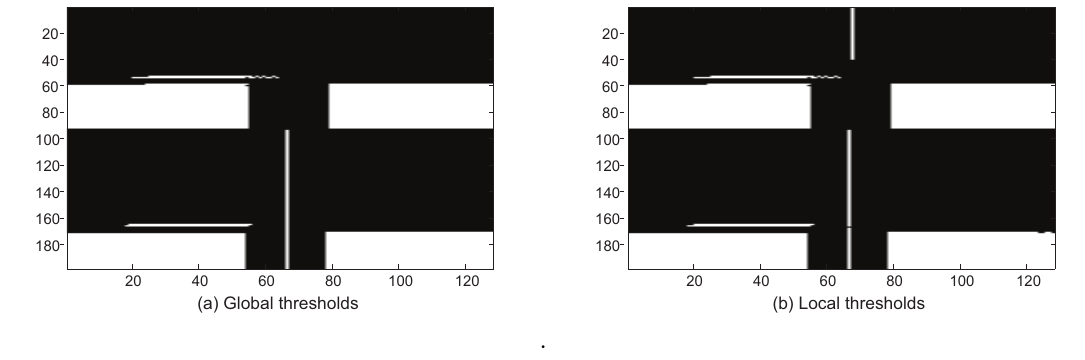
Figure 6. Comparison between global and local thresholds.